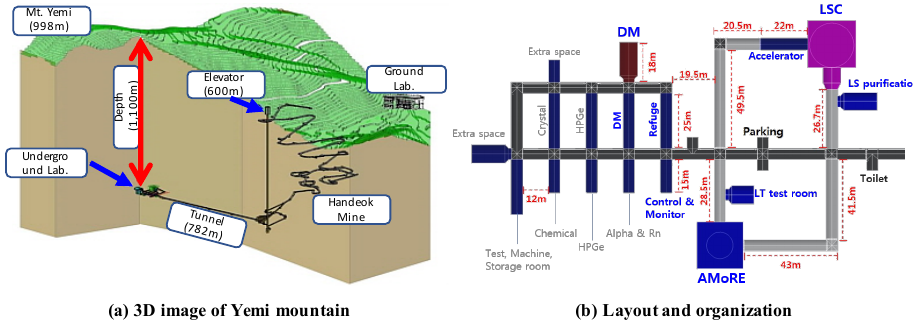
Figure 13. Jeongseon Yemilab. ( a ) Three-dimensional image of Yemi mountain and ( b ) layout and organization of Yemilab [21].